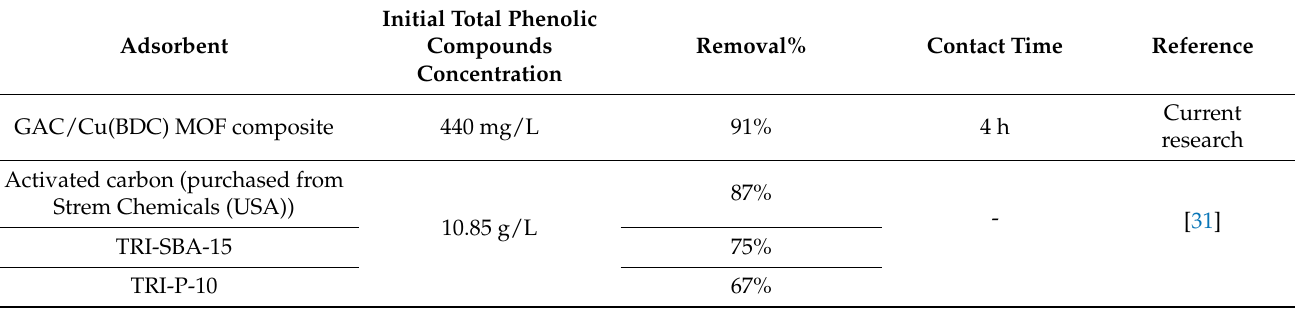
Table 2. Efficiency of different adsorbents used for phenolic compounds removal from OMW in the literature, compared to adsorbent prepared in this